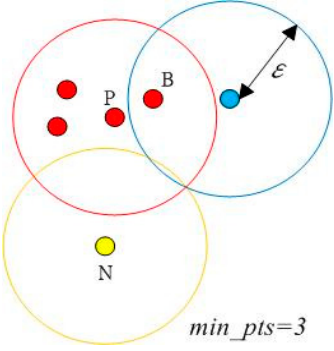
Figure 3. Core point, border point, and noise point.